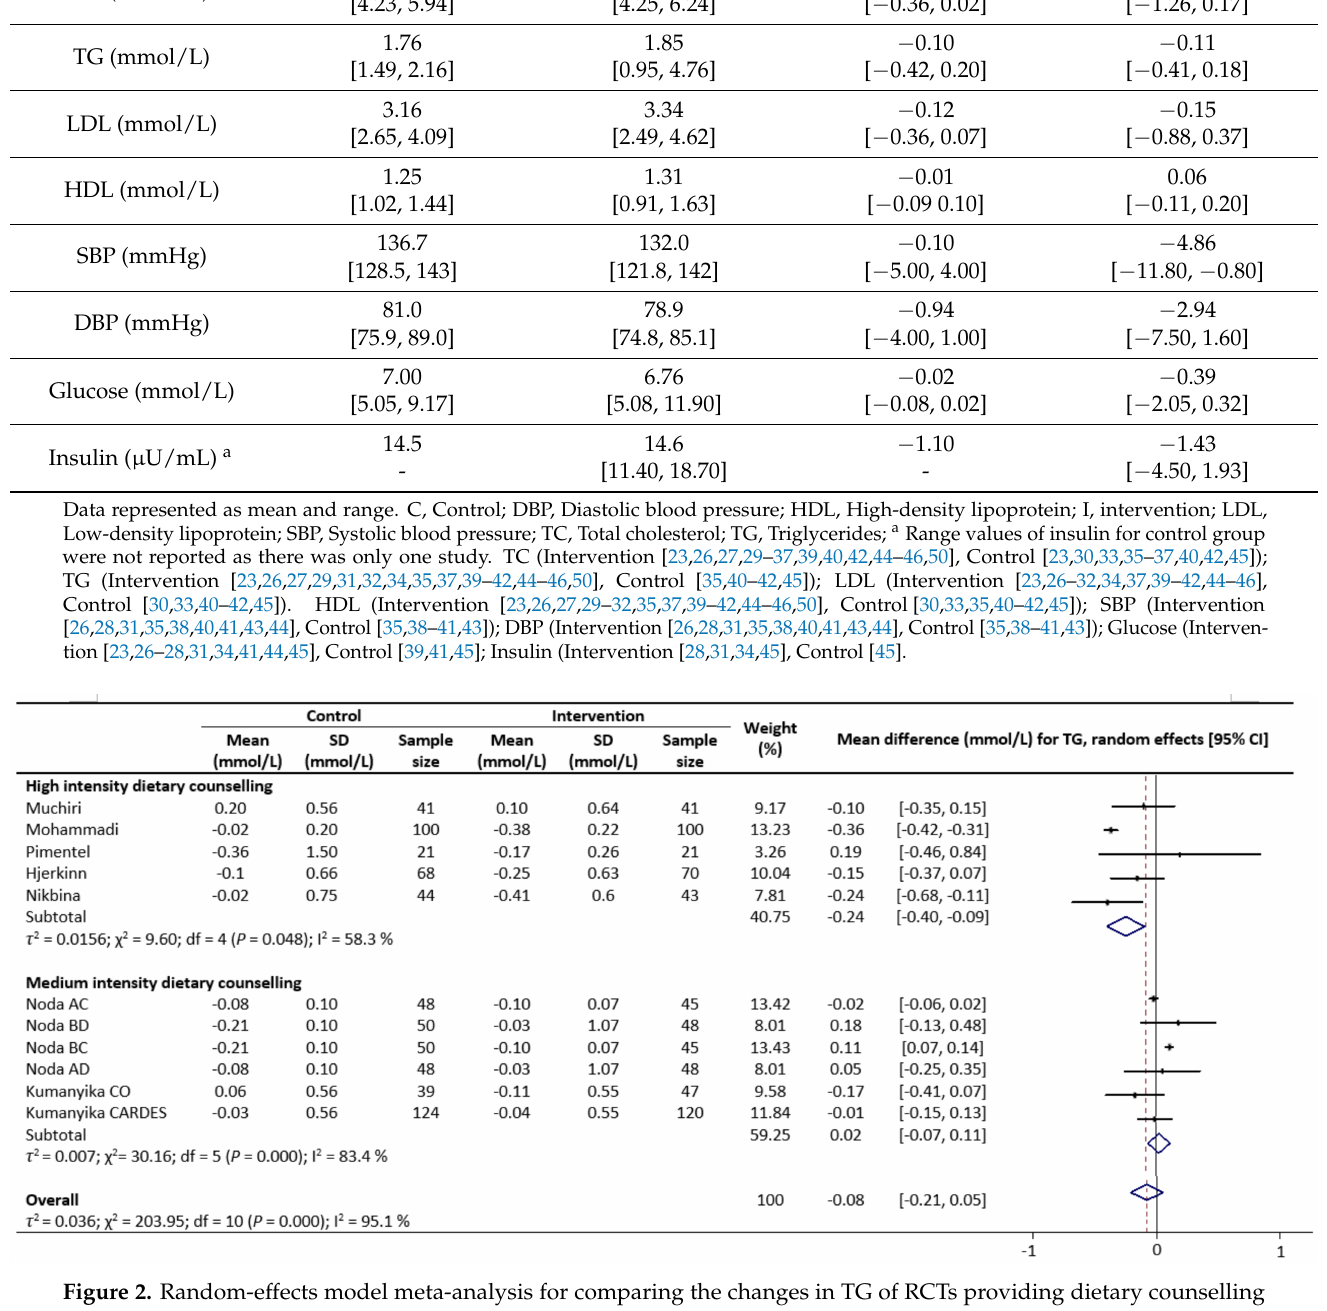
Table 3. Summary of post and change values in lipid-lipoproteins, blood pressure, glucose, and insulin of all the 22 studies. Post Change Outcome (Unit) Control Intervention Control Intervention 5.25 5.41 − 0.10 − 0.19 TC (mmol/L) [4.23, 5.94] [4.25, 6.24] [ − 0.36, 0.02] [ − 1.26, 0.17] 1.76 1.85 − 0.10 TG (mmol/L)